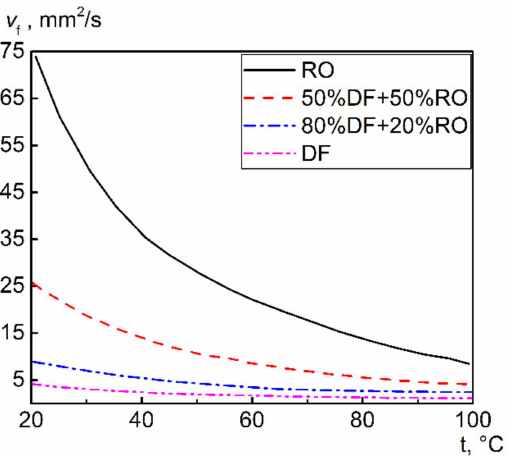
Figure 1. Viscosity-temperature characteristics of RO, DF, and DF-RO